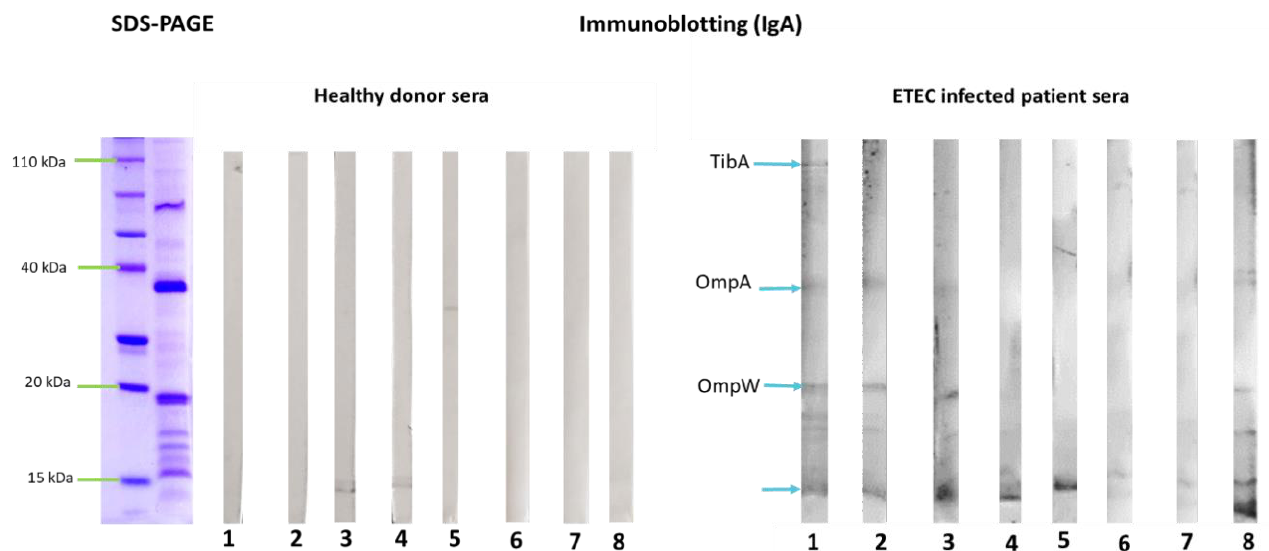
Figure 3. IgA reactivity with outer membrane vesicles (OMVs) isolated from two clinical Enterotoxi- genic Escherichia coli (ETEC) isolates incubated with ETEC infected patient’s sera (n = 8) or healthy donor’s sera (n = 8). Protein-binding sites were blocked with 5% skimmed milk in PBS at room temperature overnight. After incubation with sera, the membranes were treated with peroxidase (PO)-conjugated secondary antibody GAHu/IgA (Fc), HRP conjugate (1:1000) for 60 min at room temperature. The antibody–antigen complexes were visualized by addition of a substrate/chromogen solution (H 2 O 2 /4-chloro-1-naphthol). Blue arrows indicate previously identified OMV proteins that were recognized by IgA antibodies.